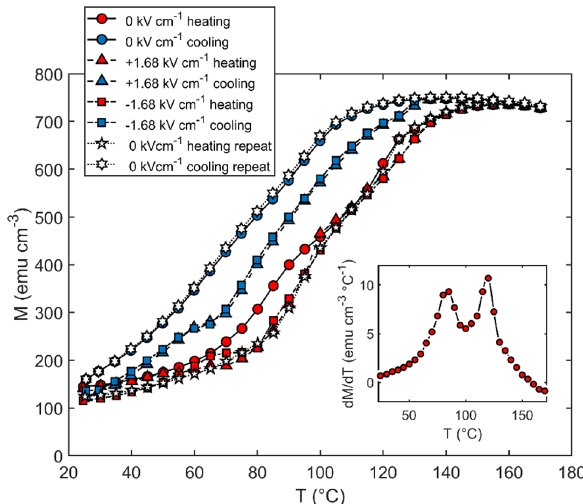
Figure 3. Thermomagnetic measurements of PMN-PT/FeRh with constant applied electric fields of 0 kV cm −1 (circles), + 1.68 kV cm −1 (triangles), and − 1.68 kV cm −1 (squares). Also shown are measurements made after resetting the electric field to zero (pentagrams and hexagrams for heating and cooling respectively). In the inset, d M /d T is shown for the heating branch of the zero electric field